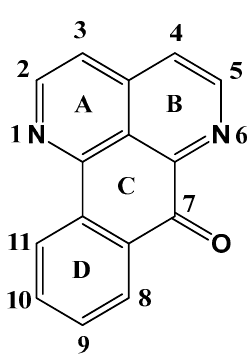
Figure 4. Sampangine molecular structure.